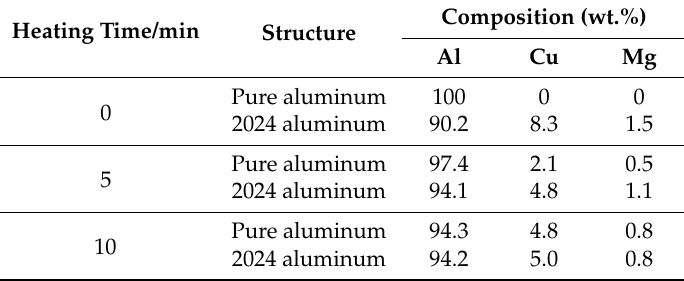
Table 1. Compositions of different structures of the bulk alloy heated at 640 ˝ C for different lengths of time.